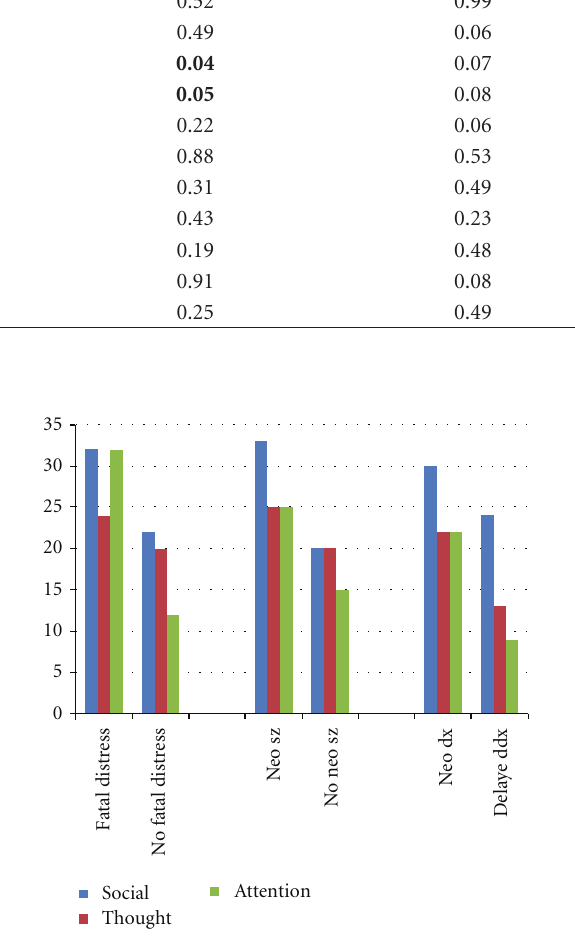
Figure 1: Percent of cases with T-scores ≥ 70 on Social, Thought, or Attention Problems scales of the CBCL, related to the presence or absence of fetal distress, neonatal seizures, or time of